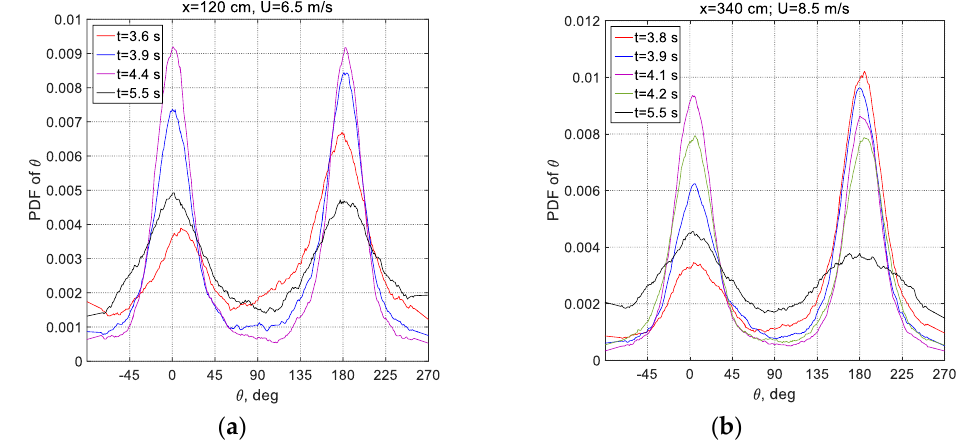
Figure 29. Probability density function of the instantaneous azimuthal angle θ at several instants during the wave growth stage. Panels ( a ) and ( b ) correspond to different fetches and wind velocities, as shown.